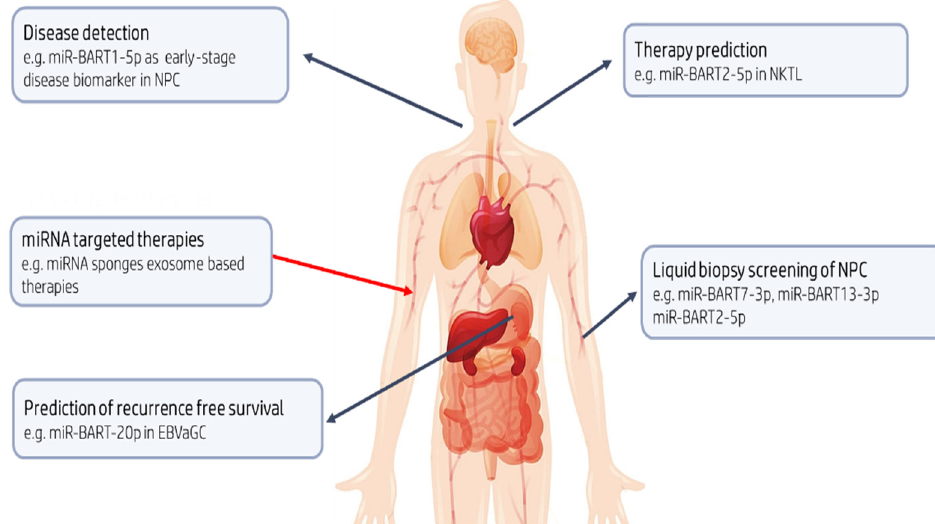
Figure 3. Potential clinical utility of EBV-encoded miRNAs. BART13-3p could aid in the detection of preclinical NPC, a cancer, which often presents late and when advanced, is associated with poor prognosis. In NKTL, which is characterized by early invasion and metastasis, miR-BART2-5p may have a role as diagnostic and predictive biomarker with the potential to identify those likely to respond to therapy. Identification of the risk of recurrence after potentially curative resection in patients with gastric cancer remains a priority; BART20-5p levels in EBVaGC might be useful in predicting recurrence free survival. Finally, rapidly emerging mRNA therapeutic technologies can be adopted to inhibit or mimic the action of miRNAs with oncogenic or tumor suppressive roles, respectively.